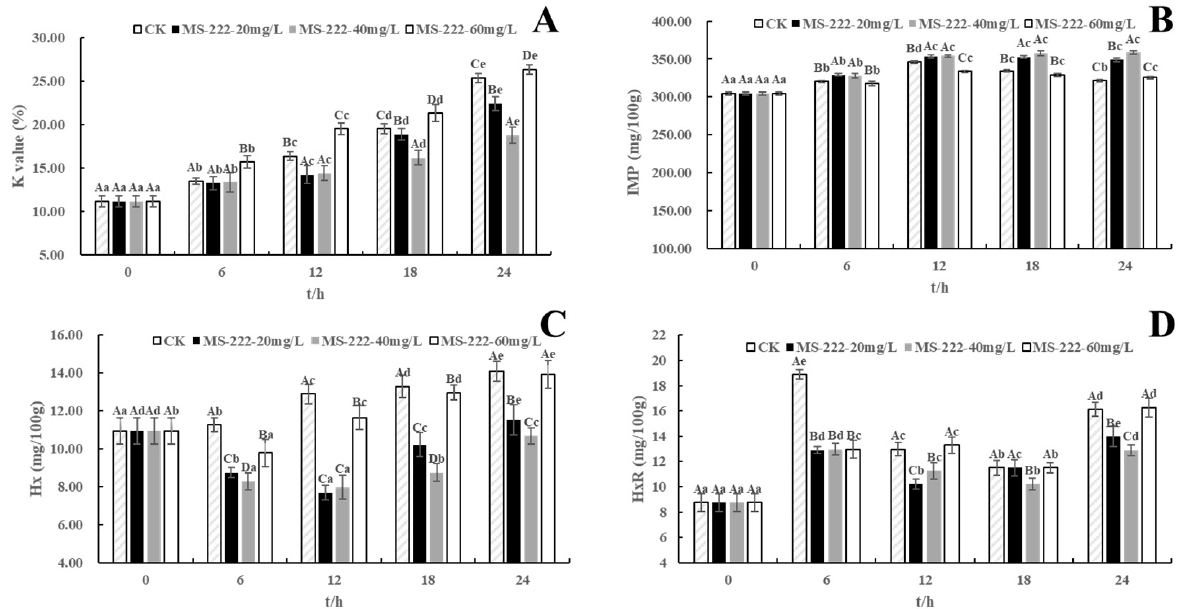
Figure 4. Changes in K values ( A ), inosine 5 ′ -monophosphate (IMP) ( B ), inosine (HxR) ( C ) and hypoxanthine (Hx) ( D ) of turbot ( Psetta maxima ) during simulated transport. Bars represent the standard deviation ( n = 3). Different capital letters indicate significant differences in the average between groups. Different lowercase letters in-dicate significant differences in the average value within each group ( p < 0.05). CK, control group.